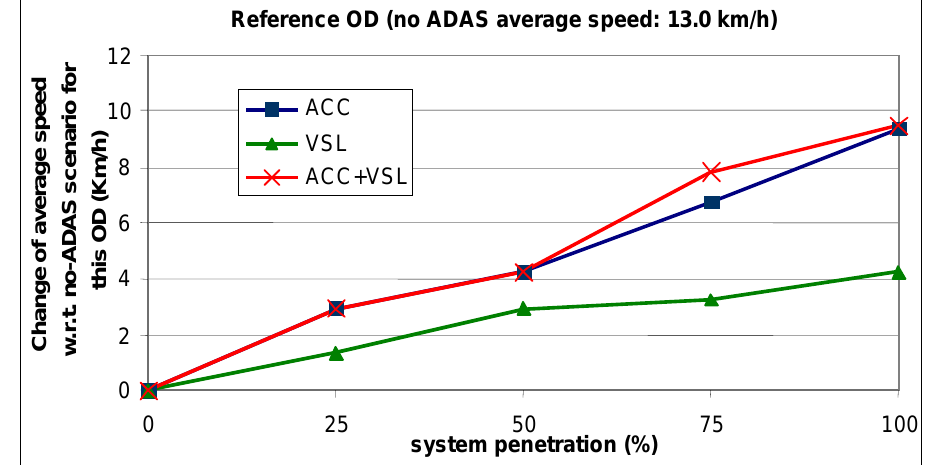
Figure 5. Network efficiency impact of all ADA